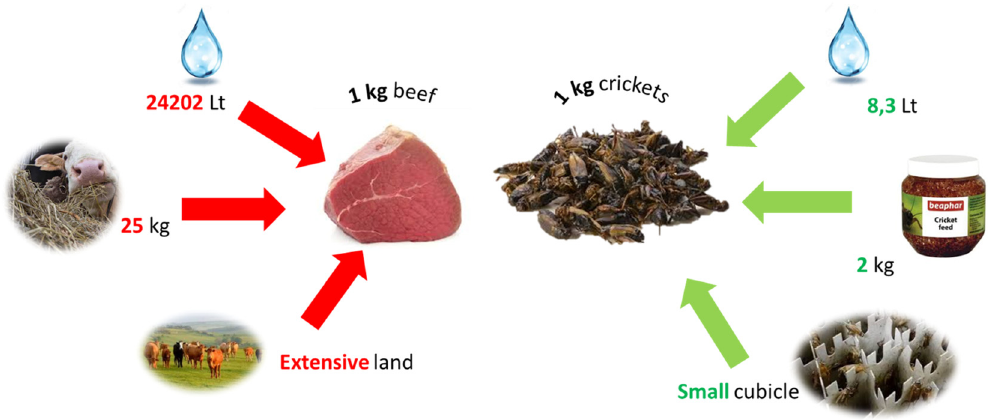
Figure 1: Comparative input/output balance in beef and cricket